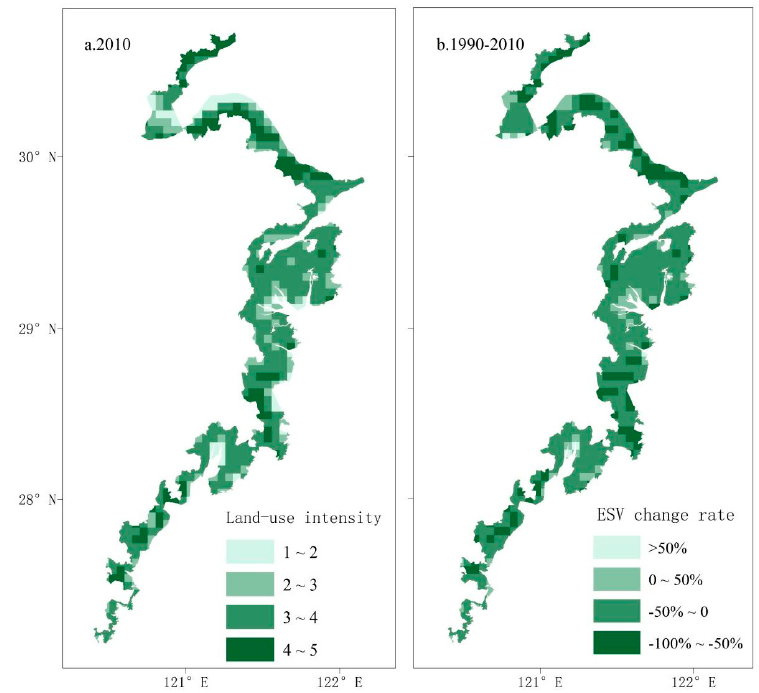
Figure 7. Comparison of land-use intensity with the change rate of ESV. ( a ) the map of land-use intensity in the year 2010; ( b ) the change rate of ESV from 1990 to 2010.